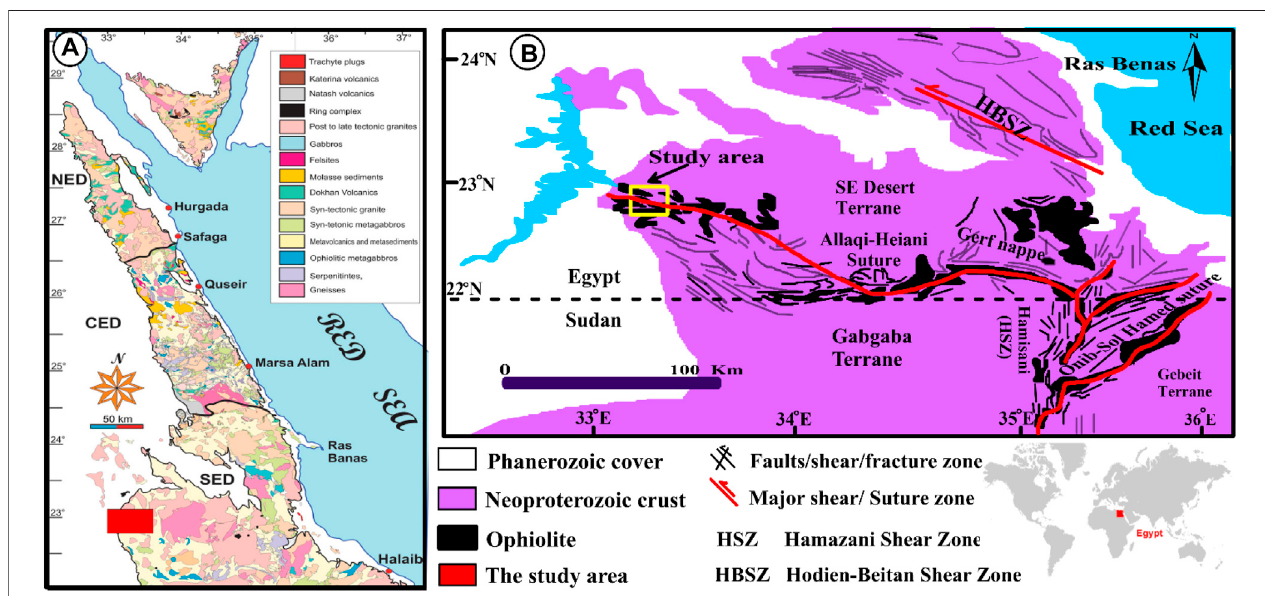
FIGURE 1 | (A) Geological map of the Egyptian Nubian Shield compiled after the geological map of Egypt (El-Ramly, 1972) and the CONCO geological maps (Klitzchetal.,1987). (B) LocationofthestudyareawithstructuralfeaturesinthesouthernpartoftheEgyptianShield,compiledfromSultanetal.(1987)andGreilingetal. (1994). Abbreviation: NED: North Eastern Desert, CED: Central Eastern Desert, and SED: South Eastern